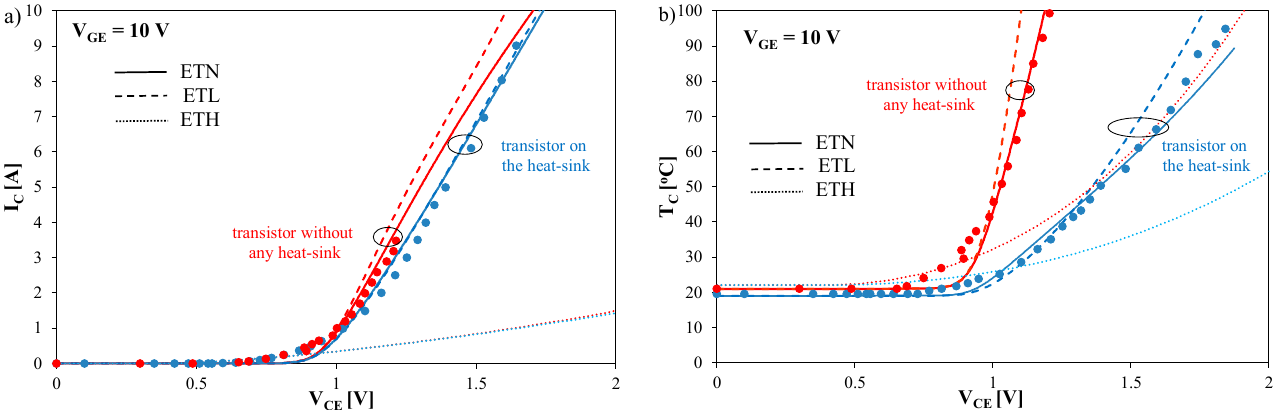
Figure 4. Computed and measured output characteristics of the tested transistor operating at strong steering ( a ) and dependences of the case temperature on voltage V CE ( b ).